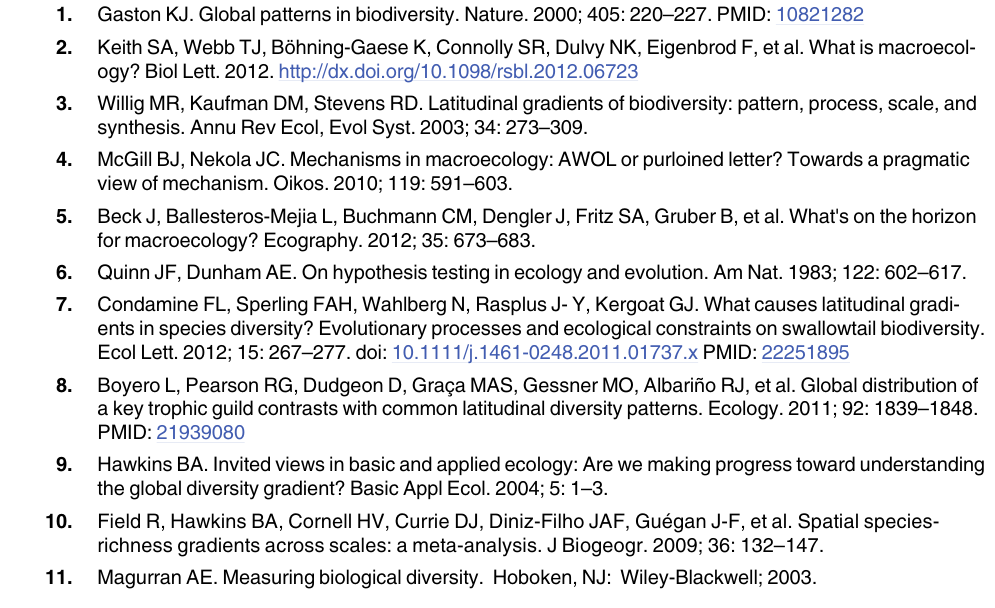
S2 Table. Relative proportion of total beetle biomass from each of the 12 sampling loca- tions, in each functional group. Molluscivores, Collembola and Mite Specialist Predators, Generalist Omnivores, Non-feeding Adults, Xylophages, and Micropolyvores have been omit- ted for clarity because their contributions to the biomass are extremely small ( < 1% of total) in all locations. S3 Table. Relationships between climatic and environmental factors, and the NMDS ordi- nations of species (left) and functional (right) assemblages found at the twelve sites. R- squared and significance values are determined using a permutational approach that fits each driver on the ordination space as a